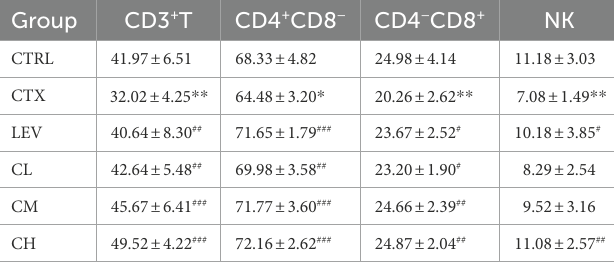
TABLE 1 Effect of complex probiotics on percentage of splenic lymphocyte subsets of CTX mice.